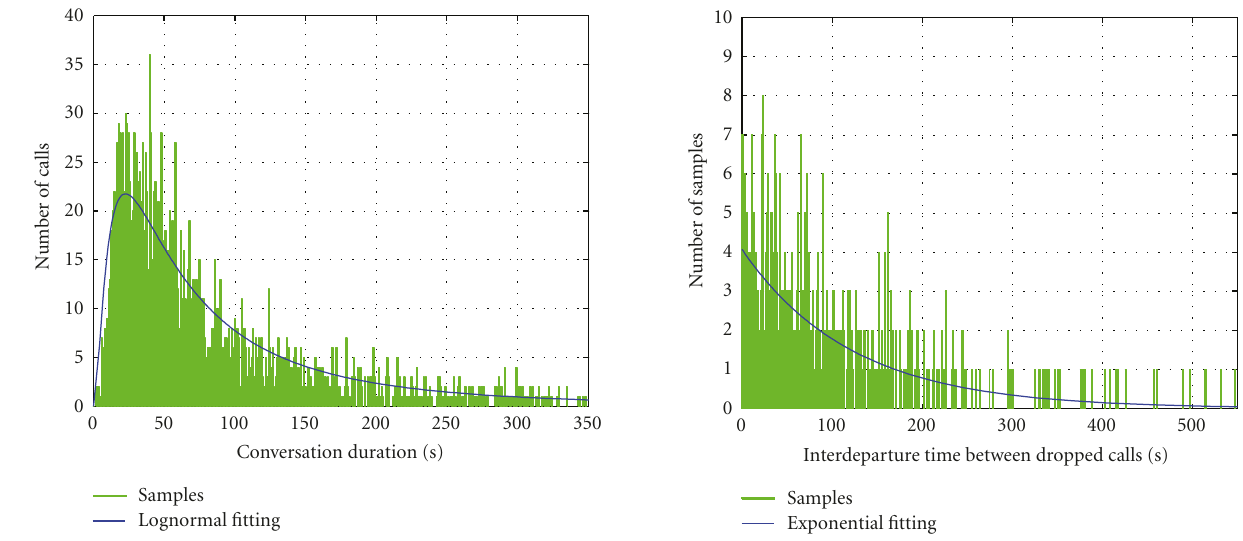
Figure 5: Fitting of conversation duration of normally terminated calls with a lognormal pdf (cell 1 observed for 4 hours).